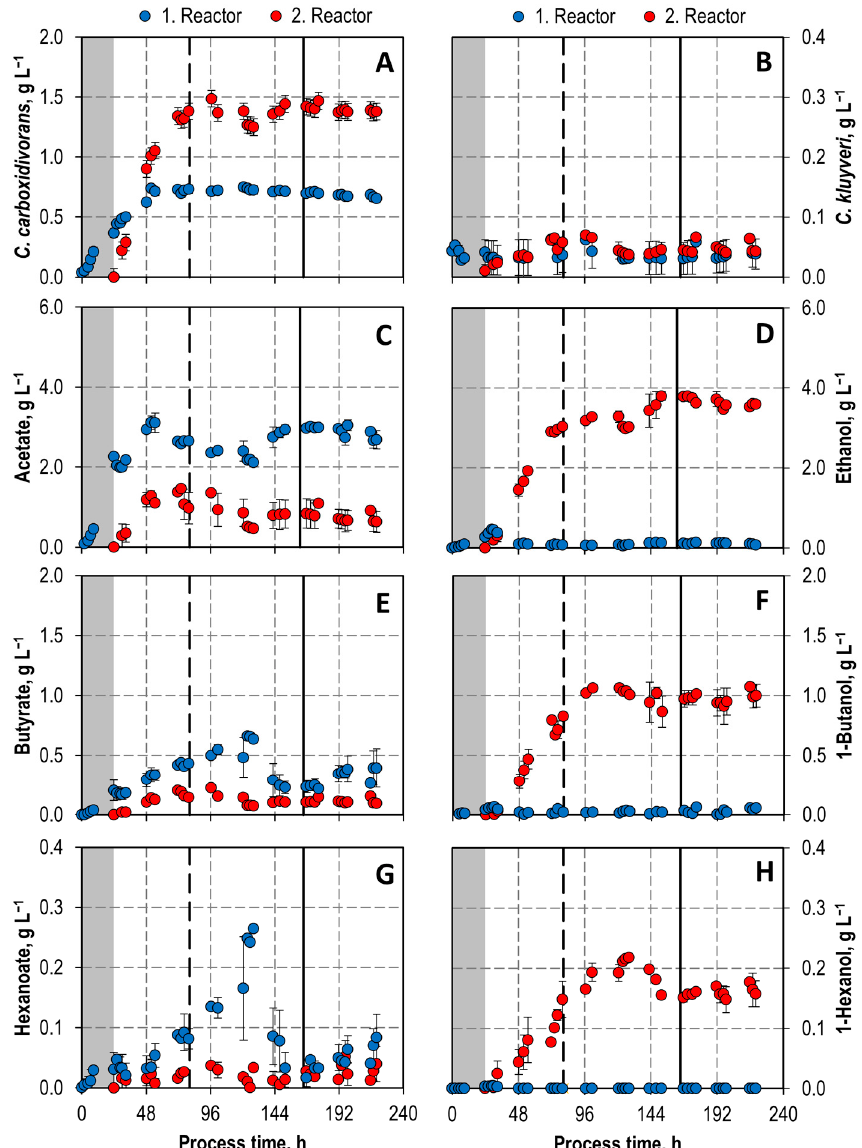
Figure 6. Biomass (( A ): C. carboxidivorans ; ( B ): C. kluyveri ) and product concentrations (( C ): acetate; Figure 6. Biomass ( A : C. carboxidivorans ; B : C. kluyveri ) and product concentrations ( C : acetate; D : ( D ): ethanol; ( E ): butyrate; ( F ): 1-butanol; ( G ): hexanoate; ( H ): 1-hexanol) during autotrophic co- ethanol; E : butyrate; F : 1-butanol; G : hexanoate; H : 1-hexanol) during autotrophic co-cultivation of cultivation of C. carboxidivorans and C. kluyveri in a continuously operated stirred-tank C. carboxidivorans and C. kluyveri in a continuously operated stirred-tank bioreactor cascade with a